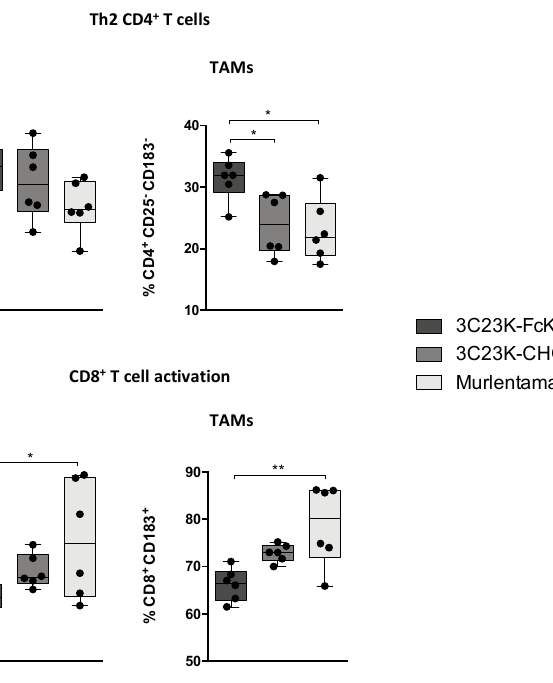
Figure 4. Murlentamab opsonization of SKOV3-R2 + activates an effective anti-tumor T cell immune response. SKOV3-R2 + ovarian tumor cells were labeled with different 3C23K antibodies (3C23K-FcKO control, 3C23K-CHO normally fucosylated or murlentamab the low fucosylated form) and cultured in the presence of human monocyte-derived macrophages from healthy donors unstimulated (M0) or stimulated with M-CSF and IL-10 (TAMs). After 3 days of co-culture, activated T cells coming from the same healthy donor were added in the culture well for 4 more days. ( A ) The CD4 + Th1/Th2 polarization profile, ( B ) the proportion of CD3 + CD4 + CD25 + regulatory T cells and ( C ) the activation of T CD8 + cells were determined by flow cytometry after four days of co-culture. Data shown (boxplots) are the results from two different experiments (performed with two different healthy donors). * p < 0.05; ** p < 0.01; *** p < 0.001. p values were determined using one-way ANOVA analysis followed by Tukey’s multiple comparisons test.